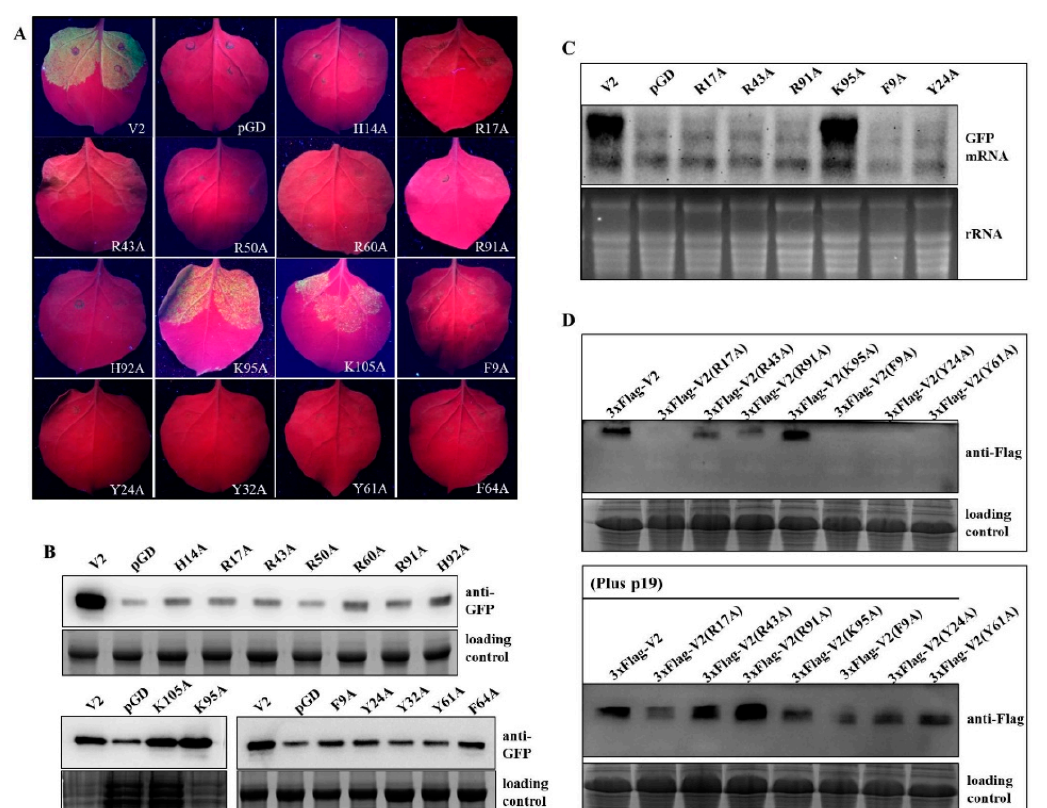
Figure 3. Silencing suppression activity of substitution mutants of V2. ( A ) Co-infiltration of wild-type N. benthamiana leaf patches with pGD-GFP and one of the substitution mutants of V2 including H14, R17, R43, R50, R60, R91, H92, K95, K105, F9, Y24, Y32, Y61 and F64. Co-infiltration with pGD-GFP and pGD or pGD-V2 served as negative and positive control, respectively. Photographs were taken at 3 dpa. ( B ) Western blot analyses of the GFP protein accumulation in leaf patches infiltrated with different constructs at 3 dpa. The Coomassie-blue-stained gel served as a loading control. ( C ) Northern blot analysis of green fluorescent protein (GFP) mRNA extracted from the agroinfiltrated regions. Blots were hybridized with probes specific for GFP mRNA. Ethidium-bromide-stained rRNA was used as an RNA loading control. ( D ) Western blot analyses of the accumulation of flag-tagged V2 and V2 mutants. “Plus p19” indicates the presence of tomato bushy stunt virus-encoded p19. The Coomassie-blue-stained gel served as loading